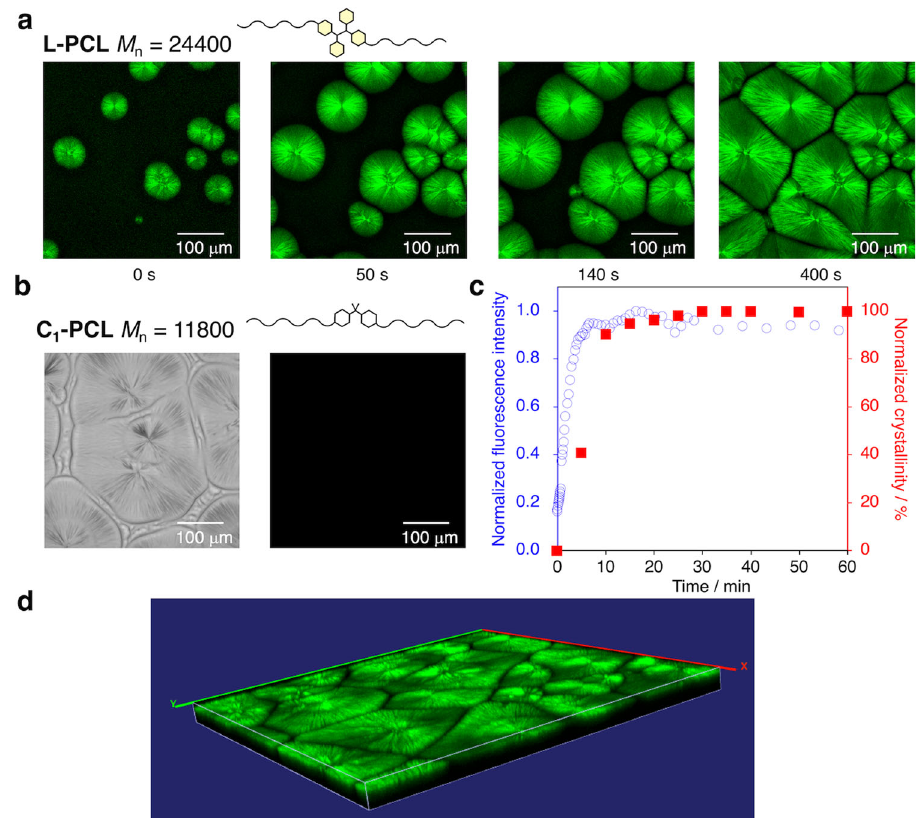
Fig. 4 Visualization of micro-mechanical forces during isothermal crystallization. a Microscopic images of L-PCL ( M n = 24,400) captured by confocal laser scanning microscopy (CLSM; λ ex = 514 nm; scale bar: 100 μ m) during isothermal crystallization. b Microscopic images of C-PCL ( M n = 11,800) under bright- fi eld conditions (left) and under excitation (right; λ ex = 514 nm; scale bar: 100 μ m) during isothermal crystallization. c Normalized fl uorescence intensity (blue open circles) and normalized crystallinity (red closed squares) during isothermal crystallization for L-PCL ( M n = 24,400). d 3D image of L-PCL ( M n = 24,400) alpha mode captured by CLSM ( λ ex = 514 nm; scale bar: 100 μ m) after isothermal